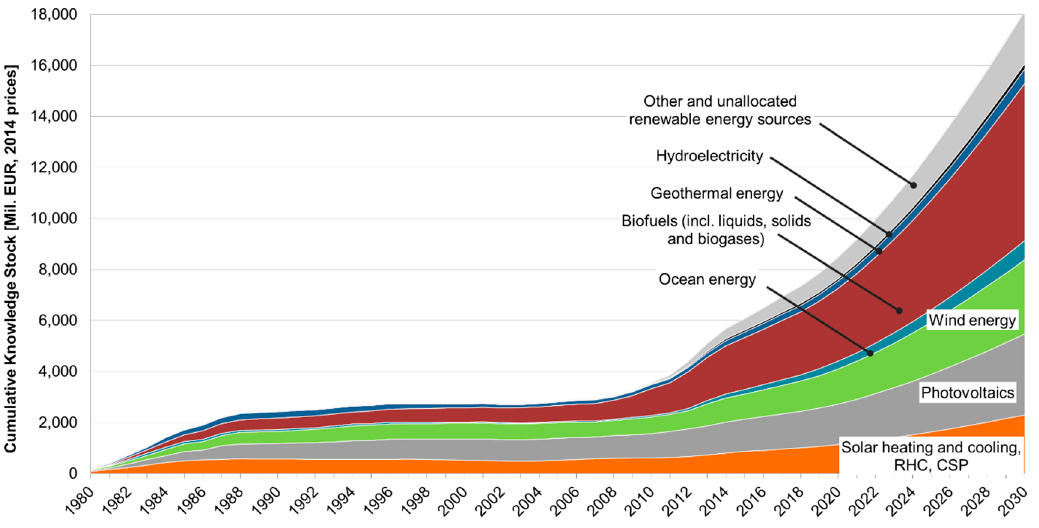
Figure 6. Cumulative RES knowledge stock by public R&D expenditures of the EU MS (Mil. EUR, Advanced scenario) (2014 prices and exc. rates; knowledge depreciation, 10%; time lag, three years).